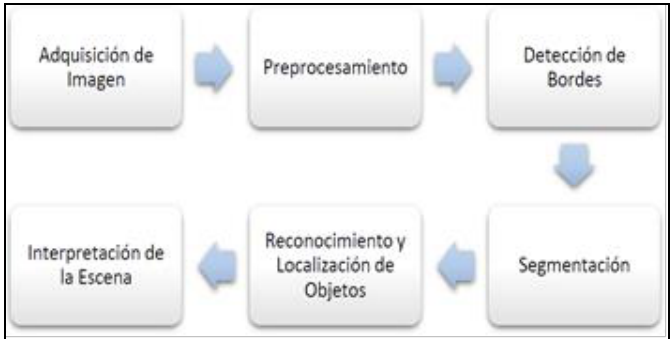
Figura 2: Etapas de un Sistema de Visión por Computador. Fuente: Los autores,